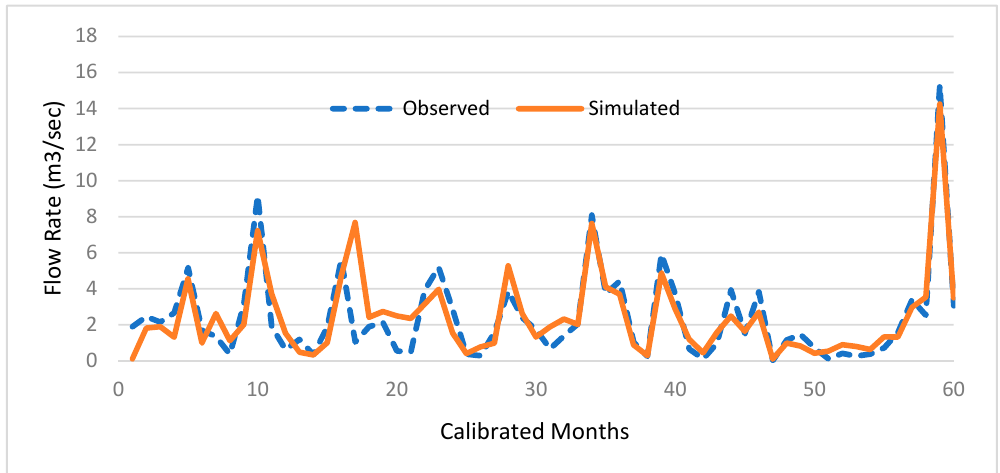
Figure 7. Calibration of the Soil and Water Assessment Tool (SWAT) model (use color) .